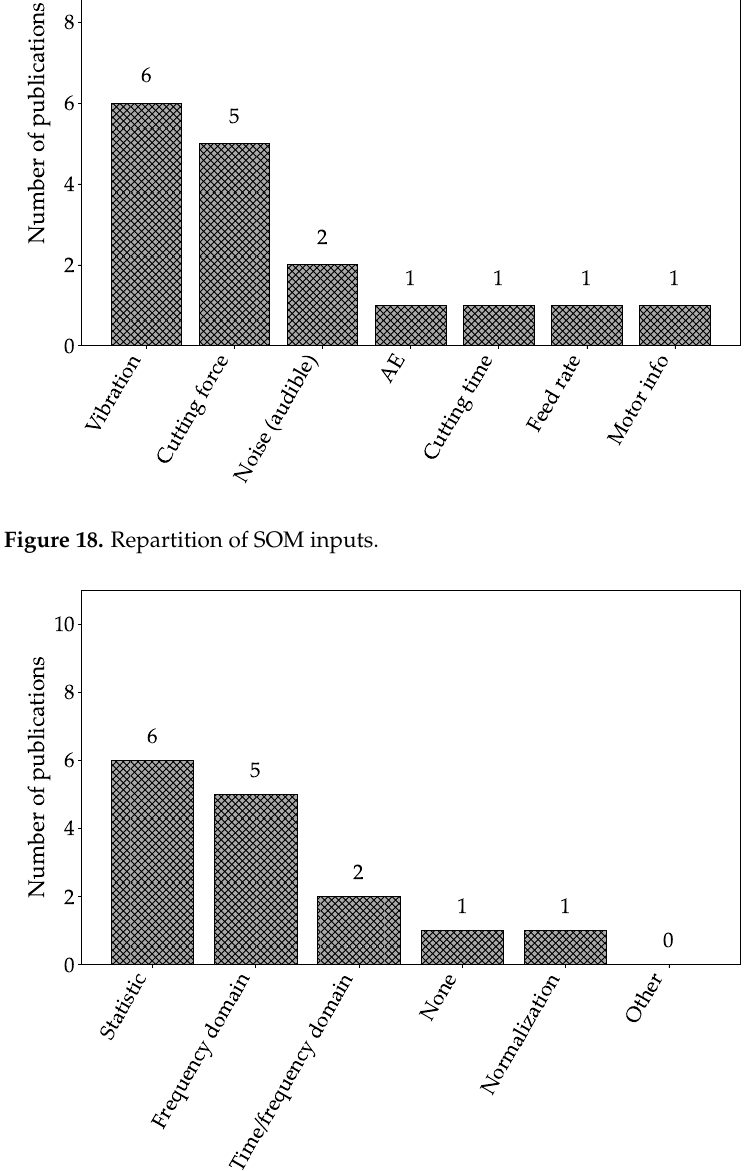
Figure 19. Repartition of SOM